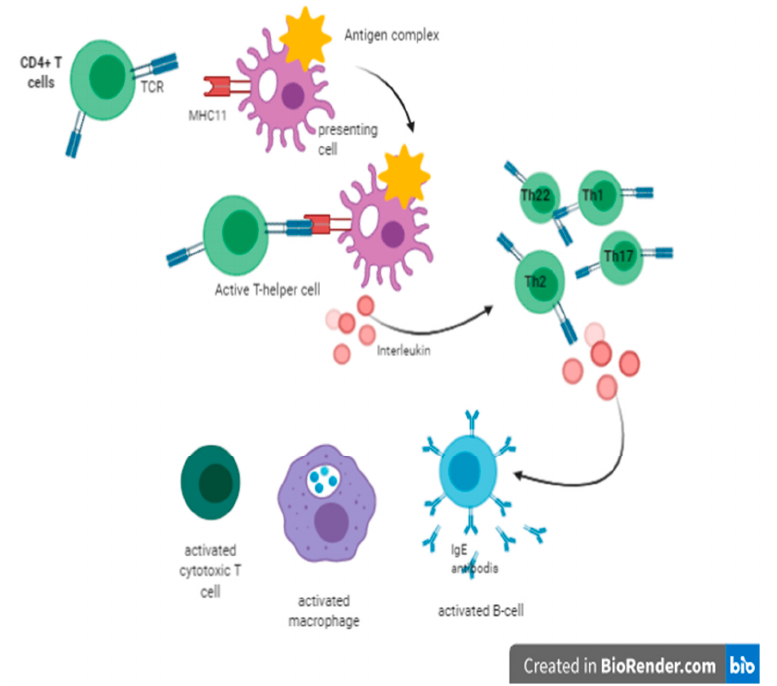
Figure 2. Antigen-presenting cells present an antigen complex with a major histocompatibility com- plex (MHC) to stimulate immature T cells to become either cytotoxic cells (CD8), when the T cell receptor binds to MHC class I, or Th cells (CD4+), when it binds to MHC class II. Once CD4 cells are activated, they will begin proliferation or clonal expansion and differentiate into Th17, Th9, Th1, Th2, and Th22 at the same time; they will secret interleukins that will stimulate a humoral immune response to produce antibodies (IgE), as well as cellular immune response and nonspecific defense by activated cytotoxic T cells and macrophages.